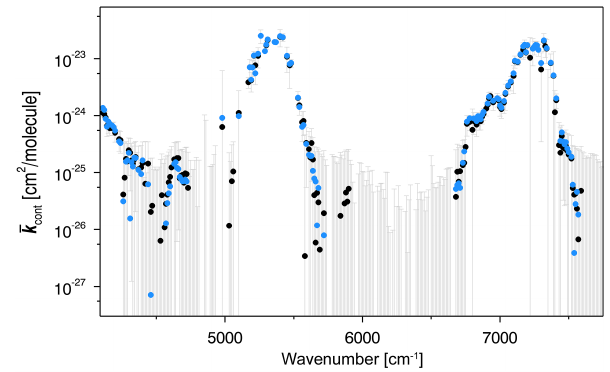
Figure 3. Mean continuum absorption coefficient derived with the method and data set described in Sect. 3 using the ESS by Menang et al. (2013) (blue data points) and by Kurucz (2005) (black data points). The different ESS sources differ by about 5% and many solar lines not present in Kurucz (2005) were included in Menang et al. (2013).